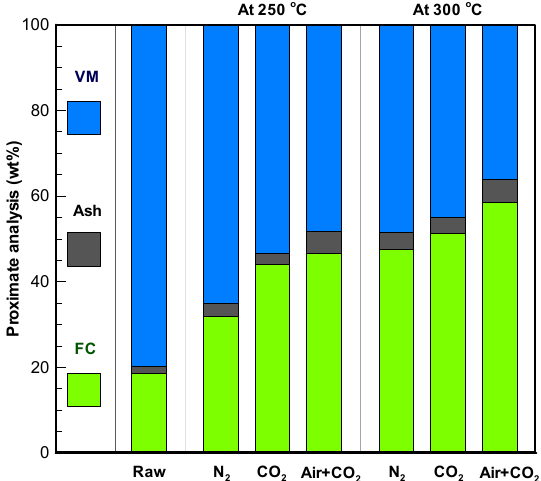
Figure 4. Proximate analyses of raw and torrefied corncob waste (dry basis).